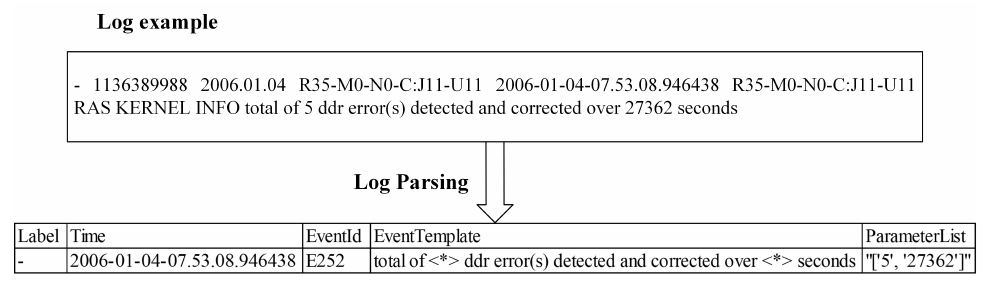
Figure 1. Overview of log